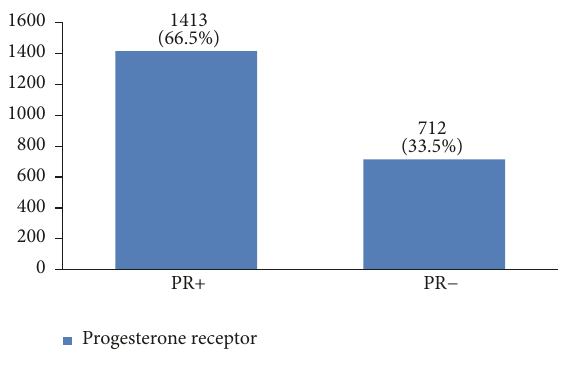
Figure 27: The percentage of progesterone receptor in the studied cases.